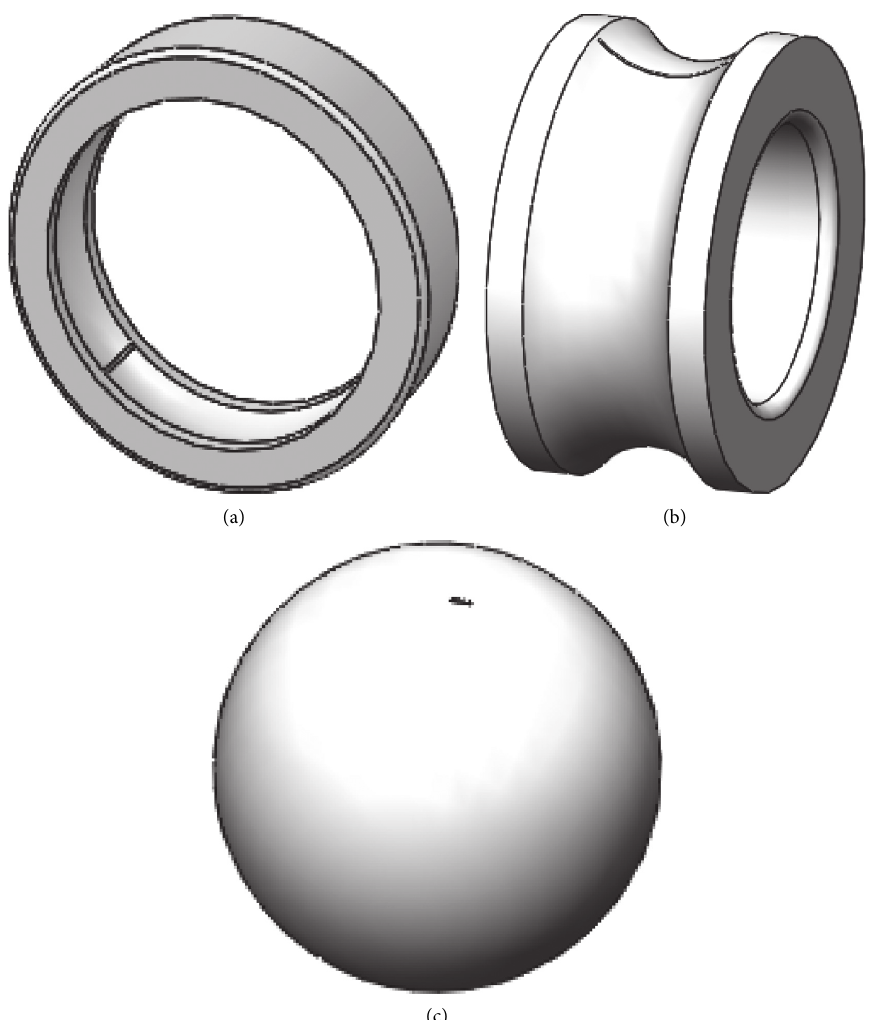
Figure 2: The fault model of rolling bearing parts. (a) Outer ring failure. (b) Inner ring failure. (c) Rolling element failure.